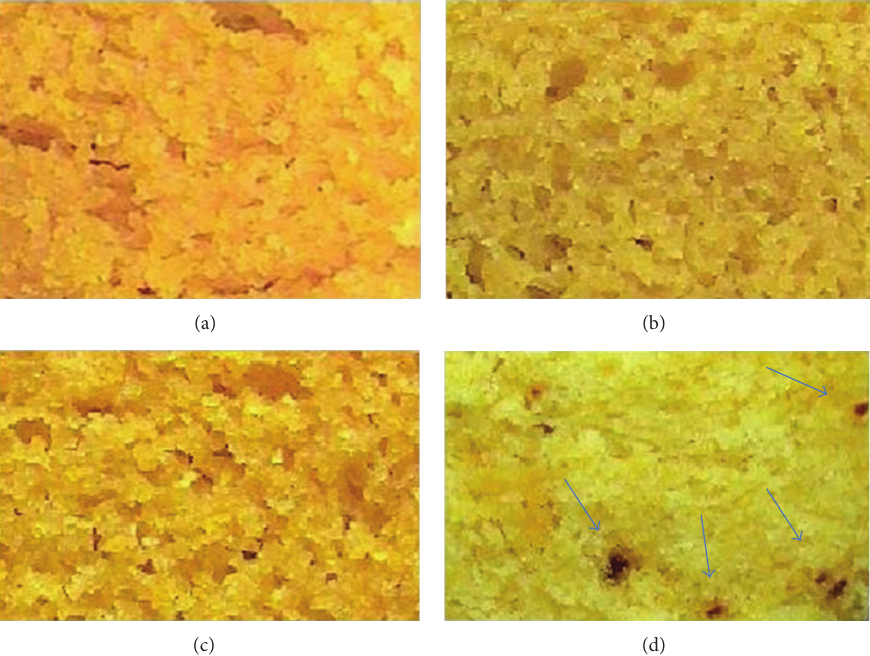
Figure 3: Distribution of lycopene in cakes: (a) free; (b) without lycopene; (c) coacervate; (d) coacervate lyophilized (arrows point to clusters of lycopene).